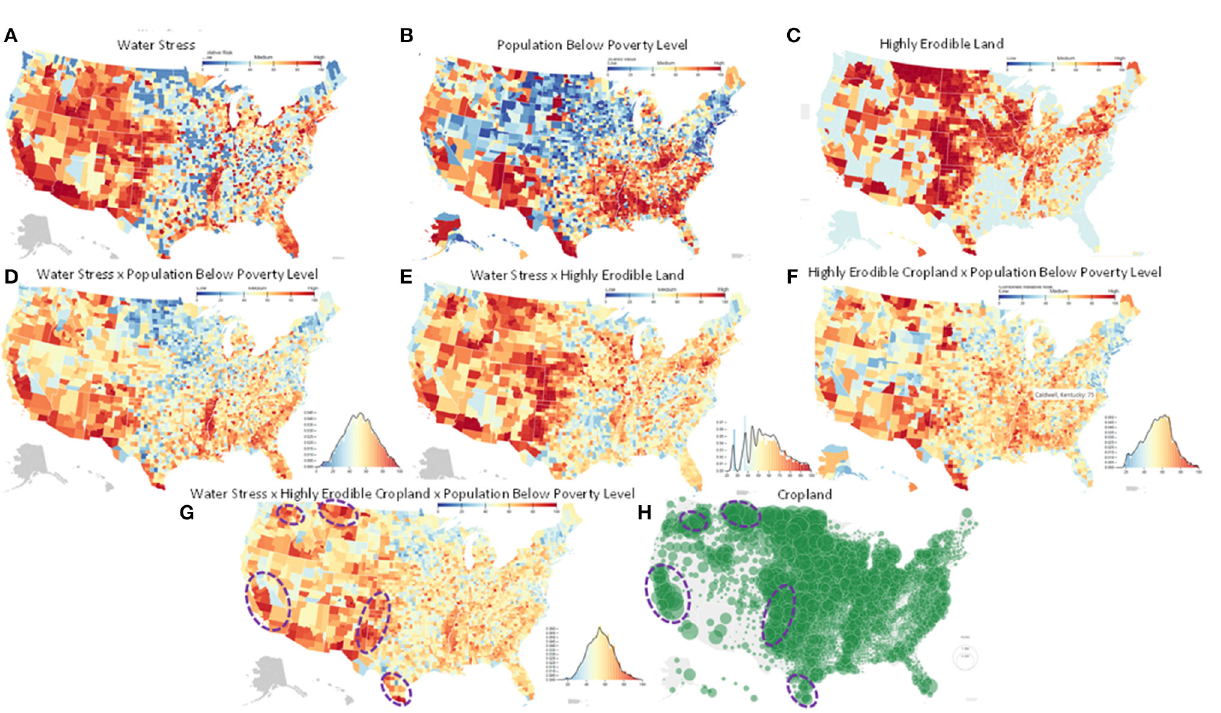
FIGURE8 Maps indicating U.S. conditions of: (A) water stress, (B) population below poverty line, (C) highly erodible land, as well as combinations of those in panels (D–G) ; and (H) cropland areas.